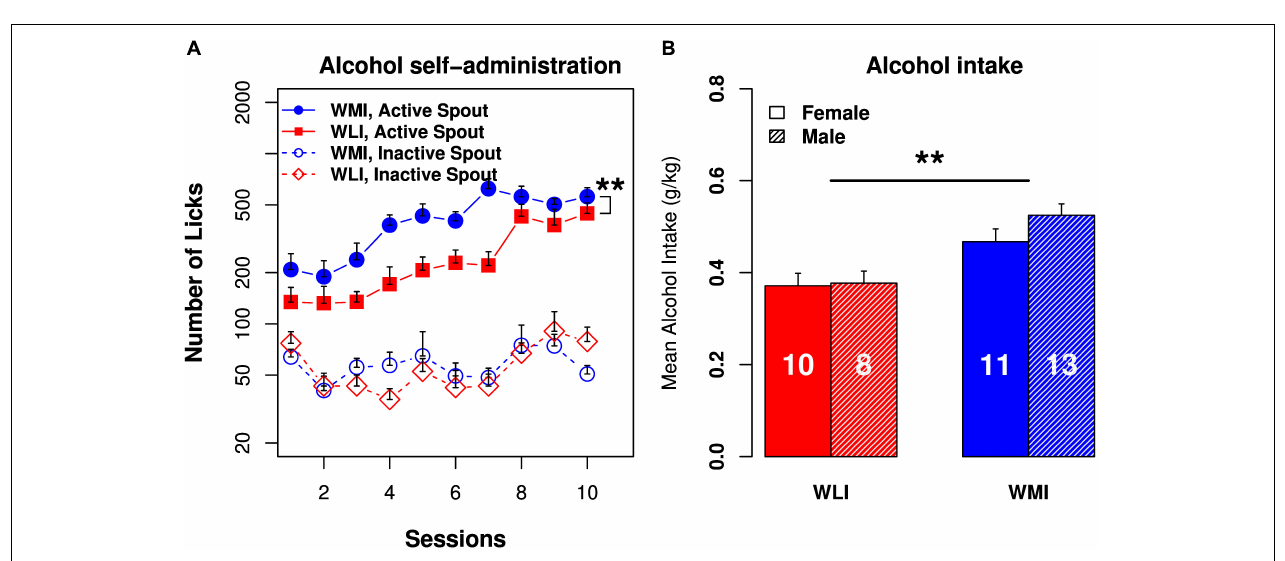
FIGURE 5 | Operant licking alcohol self-administration in WLI and WMI rats. (A) Both WMI and WLI rats licked more on the active spouts that delivered EtOH (6.5%) than on the inactive spouts. WMI licked significantly more than the WLI on the active spouts. The number of licks on the inactive spouts were not significantly different between strains. (B) Average alcohol intake per session was significantly greater in the WMI than in the WLI strain of animals. There was no sex difference in alcohol intake. Sample sizes are shown in the bar. ∗∗ p <